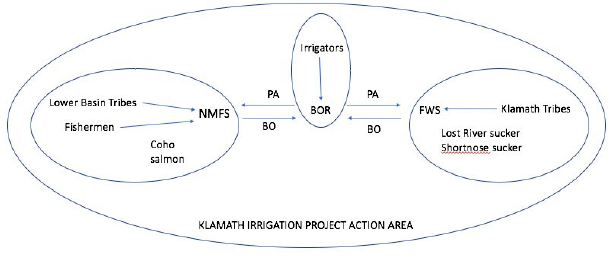
Fig. 2 . Section 7 Consultation Process pre-2013: Upper Basin/ Lower Basin Approach. Irrigators worked with Bureau of Reclamation (BOR) to develop a proposed action (PA). BOR delivered PA to U.S. Fish and Wildlife Service (FWS) and National Marine Fisheries Service (NMFS) separately. Lower Basin Tribes and fishermen sought to influence NMFS in development of coho biological opinion (BiOp). Klamath Tribes sought to influence FWS in development of